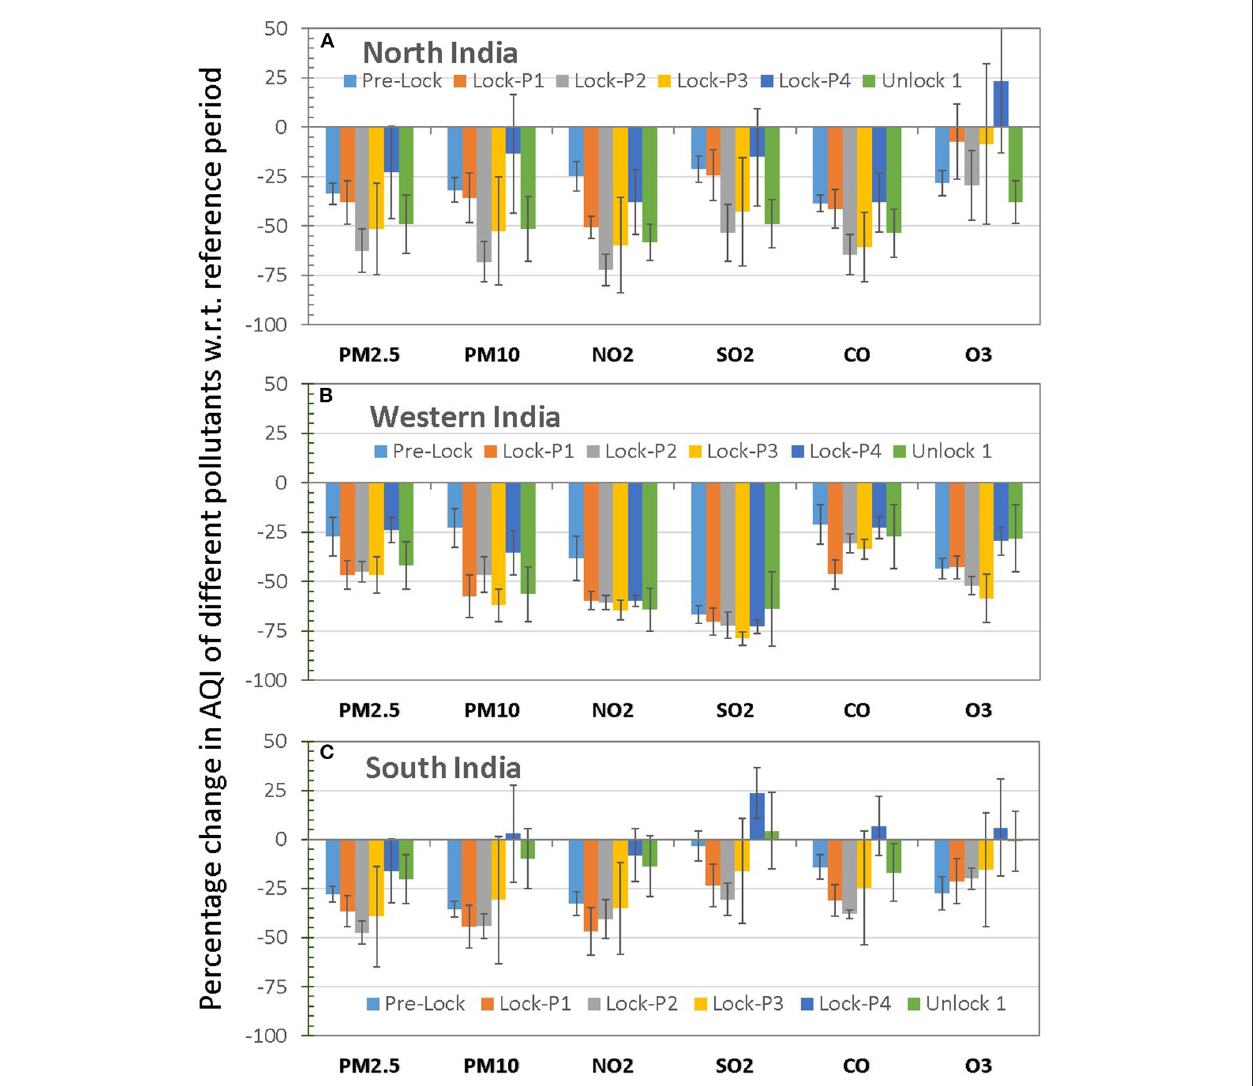
FIGURE 4 | Percent change of different air pollutants averaged on a regional basis: (A) north, (B) western, and (C) south India during different prelockdown, lockdown (P1–P4), and unlock phases. The spread bars show standard